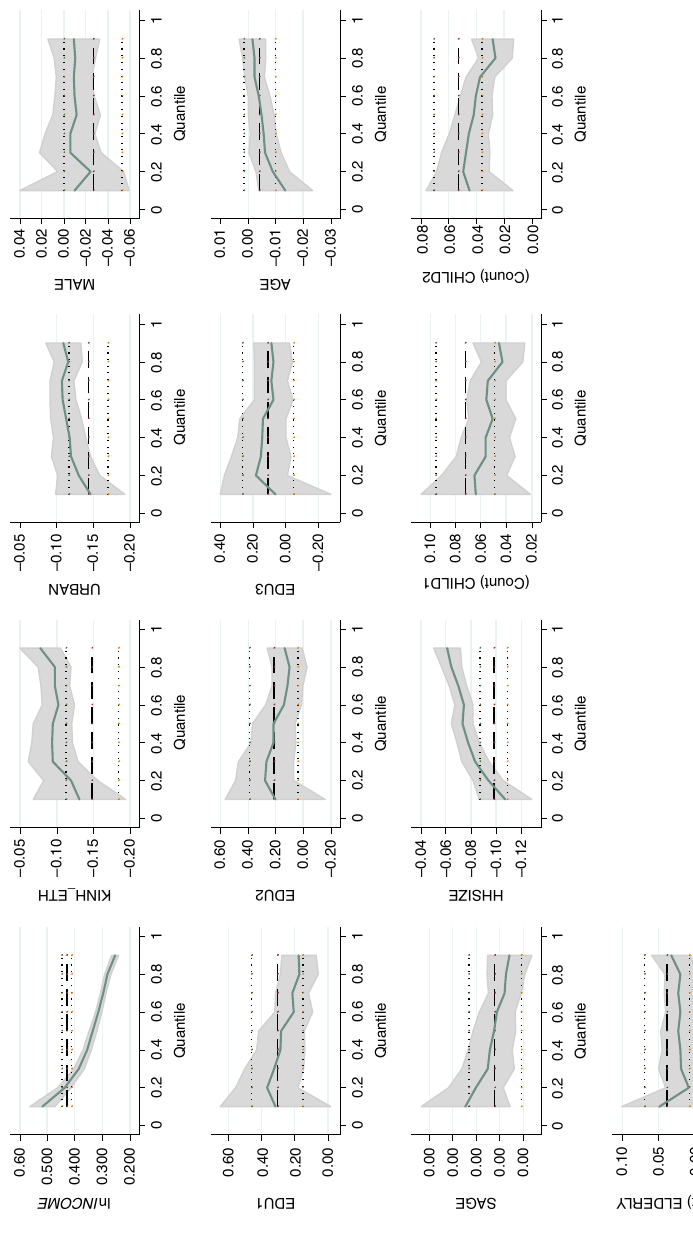
Figure 3. Ordinary least squares regression and quantile regression estimates for Vietnamese household saving